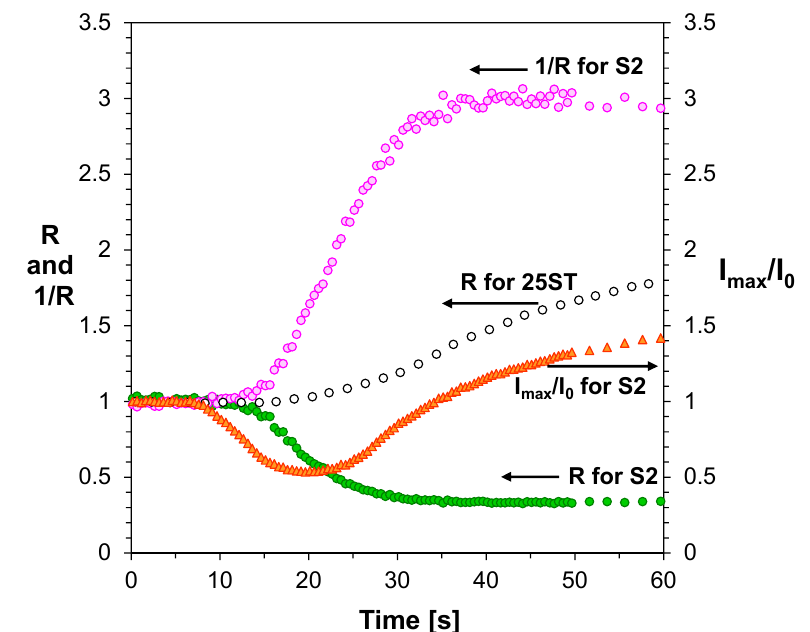
Figure 7. Kinetic profiles of cationic photopolymerization of TEGDVE monomer, obtained by FPT method, using 2-amino-4-(4-methoxyphenyl)-6-phenyl-pyridine-3-carbonitrile sensor (S2) and different kinetic parameters.